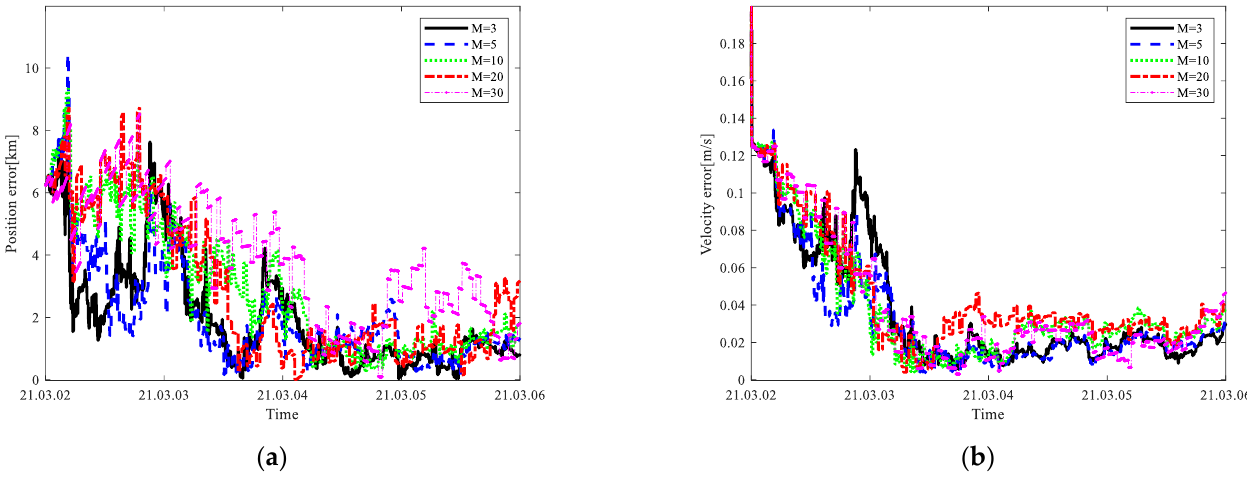
Figure 7. Navigation results of the parameter-independent event-triggered mechanism. ( a ) Position error. ( b ) Velocity error. Table 7. Navigation results of the parameter-independent event-triggered mechanism with different M .